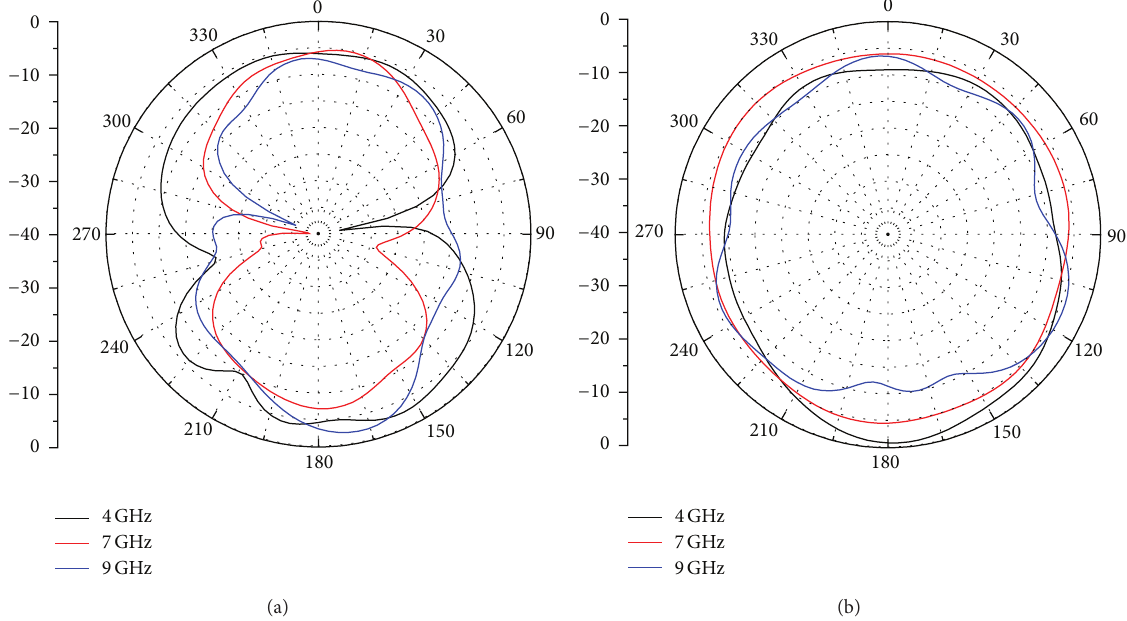
Figure 10: Measured radiation patterns at (a) E-plane and (b) H-plane.